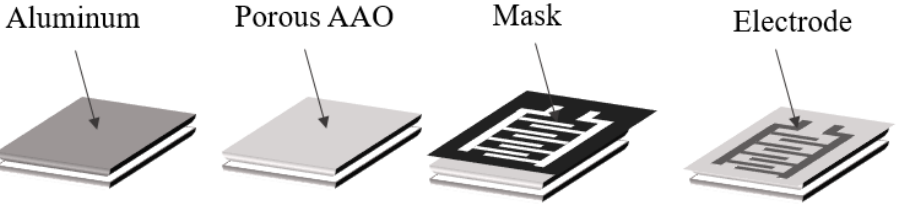
Figure 9. Schematic integration of evaporation and anodization process for AAO-nanosensor fab- rication process.